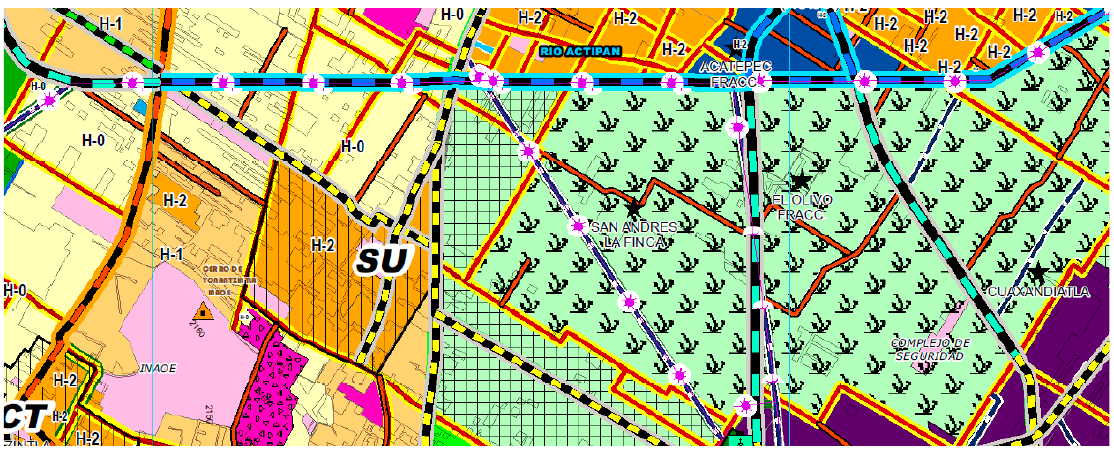
Figure 4. Land uses and densities in San Rafael Comac, Source: MPSUD (2018). In this sense, the 2018 MPSUD [17] only recognized San Luis Tehuiloyocan, another rural district, as an exclusively rural-agricultural area, and characterized San Rafael Comac as an urban sub-center, marking it out as a cultural-tourism spot. Arguing demographic growth in San Andr é s Cholula (projected to be 277,000 inhabitants by the year 2050, according to the 2018 MPSUD) the program appointed the number of developable hectares per junta auxiliar as shown in Table 2. Table 2. Developable land in San Andrés Cholula up to the year 2050. Source: MPSUD (2018). Urban Voids Junta Auxiliar (District)